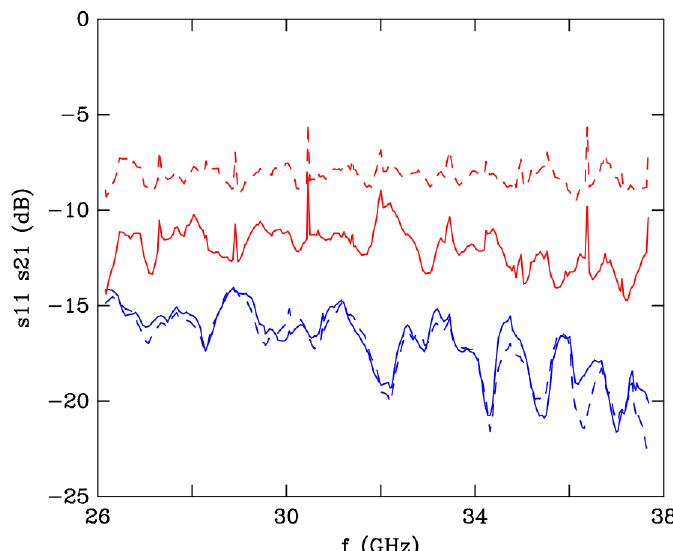
Figure 12. Variation versus frequency of the s 11 (red curves) and s 21 (blue curves) signals in dB of the structure with truncated pyramidal holes shown in the photo of Figure 7. The full-line curves correspond to the waves arriving from the largest basis of the holes, the dashed-line curves are for the reversed direction. The geometrical parameters are: d = 6.5 mm, a = 13.1 mm, c 1 = 9.0